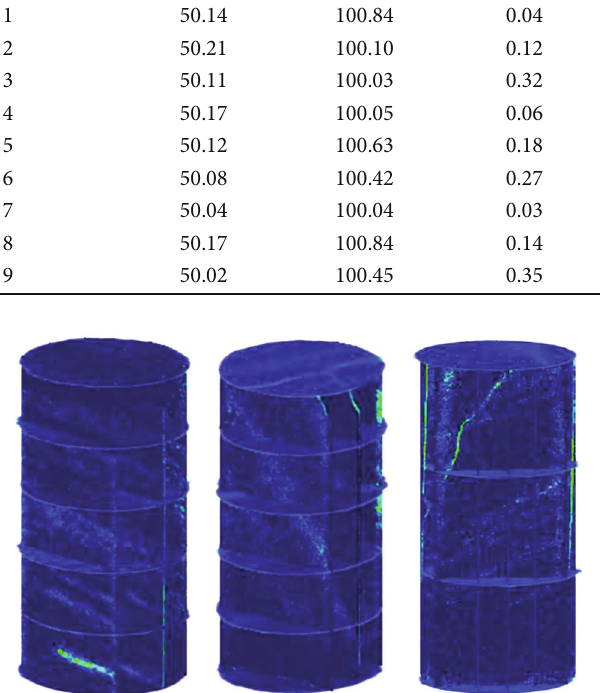
Figure 6: 3D-CAD sample reconstruction